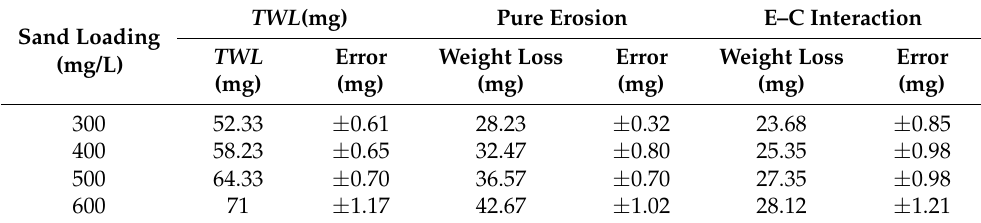
Table 3. Weight loss due to sand loading effect at 20